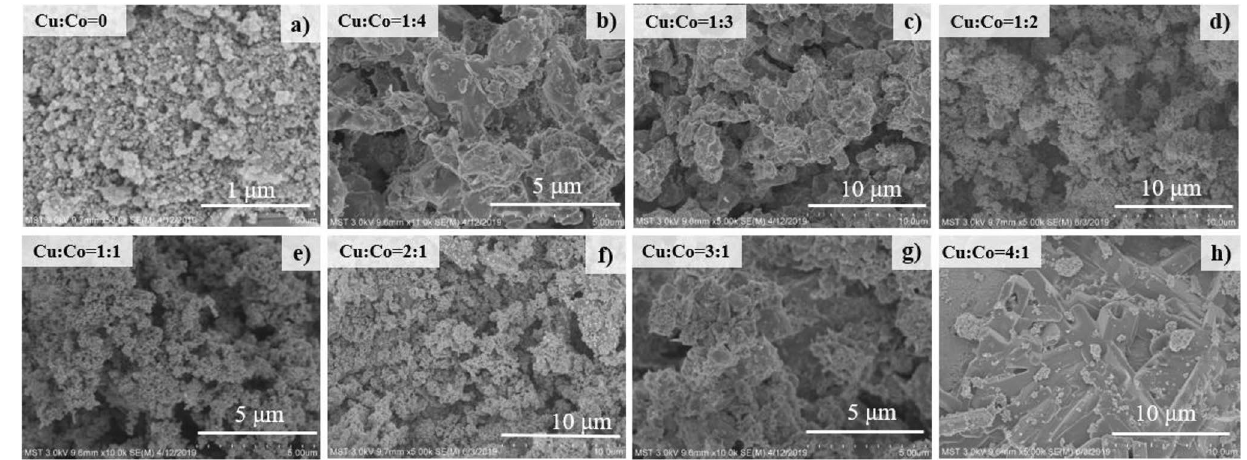
Fig. 2 SEM images of as-prepared Cu x Co 3− x O 4 samples with various binary metal ratio of copper and cobalt